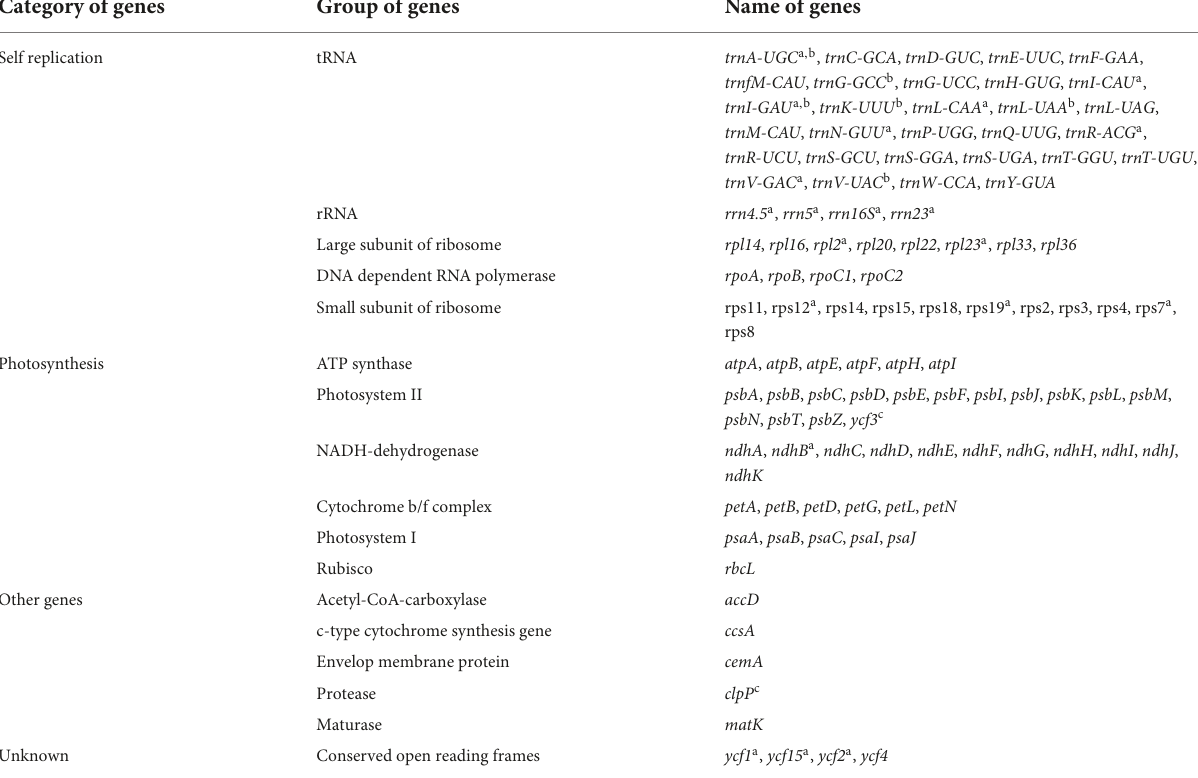
TABLE 1 List of genes in the Salix floderusii cp genome. Category of genes Group of